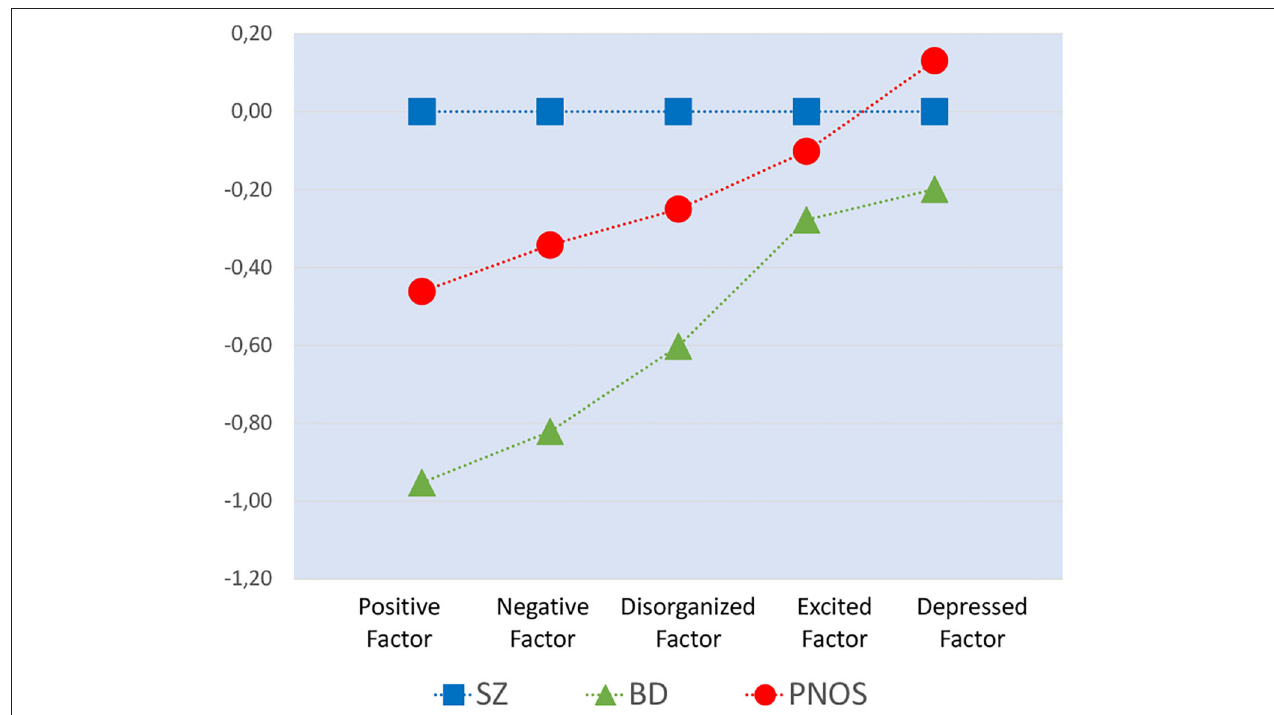
FIGURE 1 | The symptom profiles of the three diagnostic groups, based on z-scores for the five PANSS factors, with the z-scores for the BD-group and PNOS-group relative to the SZ-group. The z-scores are based on the SZ groups’ means and standard deviations. The background data for this figure are included in Table 3 . Note that the factors represent discrete categories and the dashed lines are used for illustration